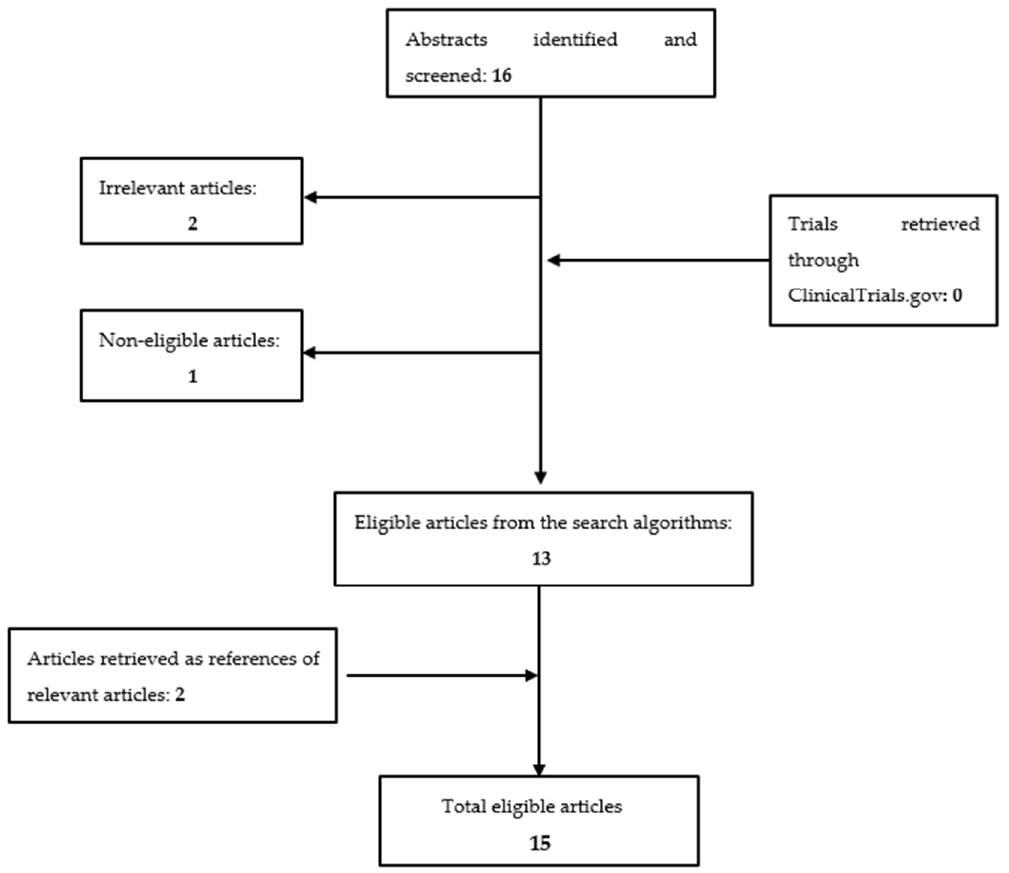
Figure 1. Flowchart presenting the successive steps during the selection of studies. According to our results, six microRNAs (miR-126, miR-326, miR3613-3p, miR-29b- 3p, miR-497 and miR-17-92) were implicated with sensitivity to CDK4/6 inhibitors; the first four of the aforementioned molecules were studied in breast cancer cell lines, from the second to the last one in anaplastic large cell lymphoma cell lines and the last one in atypical teratoid rhabdoid tumor cell and glioblastoma stem cell lines (Table 1). Con- versely, six microRNAs (miR-193b, miR-432-5p, miR-200a, miR-223, Let-7a and miR-21) conferred resistance to treatment with CDK4/6 inhibitors according to studies performed mainly on cell lines deriving from solid tumors (breast, prostate and metastatic mela- noma), with the exception of Let-7a and miR-21, which were upregulated in T-cell acute lymphoblastic leukemia/lymphoma cells (Table 2). An additional number of microRNAs (miR-124a, miR9, miR200b and miR-106b) were shown to mediate cellular response to CDK4/6 inhibitors in acute lymphoblastic leukemia, breast and lung cancer cells, without, however, affecting sensitivity to treatment (Table 3). The following segment contains de- tailed regulation information for each specific miRNA molecule identified in our study. 3.1. MicroRNAs Conferring Sensitivity to CDK4/6 Treatment miR-126: The study identified four miRNAs, namely miR-9, miR126, miR-181a and miR-326, as the ones with the most profound antiproliferative effect on breast cancer cell lines [43]. Combined miR-126 transfection and CDK4/6 inhibitor ribociclib application re- sulted in a greater antitumor effect than either agent alone in luminal and HER2-positive breast cancer cell lines ( p < 0.005) [43]. miR-126 downregulated genes mainly involved in the cell cycle, especially M phase and glycolysis. Collectively, miR126 upregulation sensi- tized breast cancer cells to CDK4/6 inhibition [43]. Of note, the HER2-positive breast can- cer cell line tended to be the most sensitive to miRNA and CDK4/6 inhibitor combination.